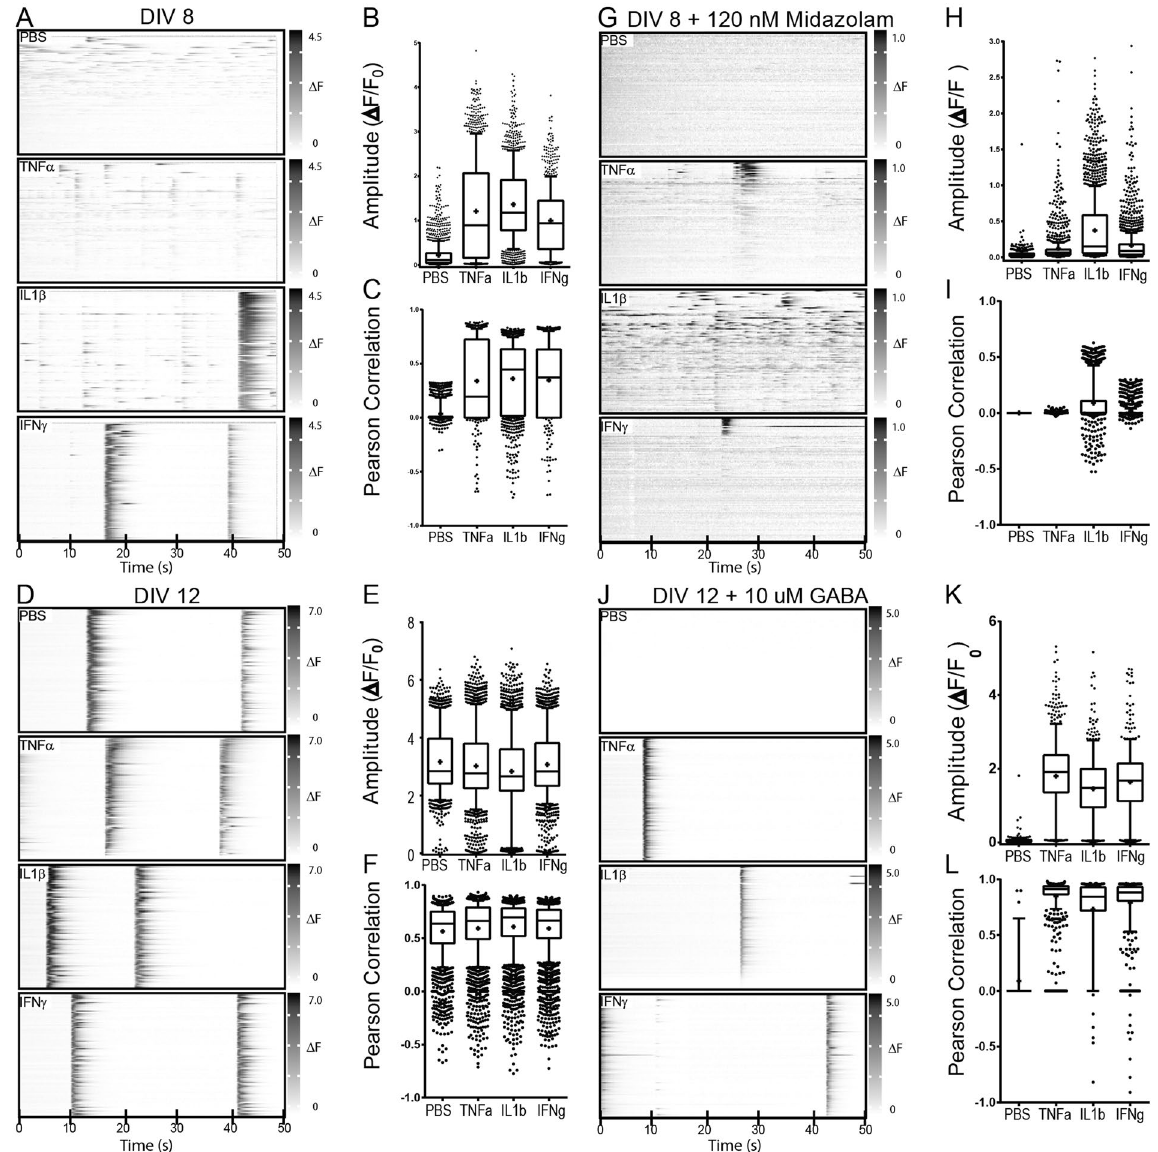
Figure 5. Cytokine treatment alters neuronal firing kinetics and increases network synchronization. Representative raster plots are shown for DIV 8 ( A , G ) or DIV 12 ( D , J ) cortical neurons treated for 24 hours with 100 ng /mL TNF- α , 100 ng/ mL IFN- γ , 10 ng/mL IL-1 β or vehicle alone (PBS). After 24 hours of cytokine stimulation, cells were treated acutely with 120 nM midazolam ( G – I ) or 10 μ M GABA ( J – L ) prior to signal acquisition. Average amplitude and Pearson correlation coefficient values are plotted for DIV 8 neurons prior to ( B , C ) and after treatment with 120 nM midazolam ( H , I ) as well as for DIV 12 neurons prior to ( E , F ) and after treatment with 10 uM GABA ( K , L ) for all ROIs across 6 wells for each of the indicated conditions. Box plots show median (line), average ( + ), and interquartile range; error bars represent 10–90% range with outliers shown. Data are representative of 2–3 independent